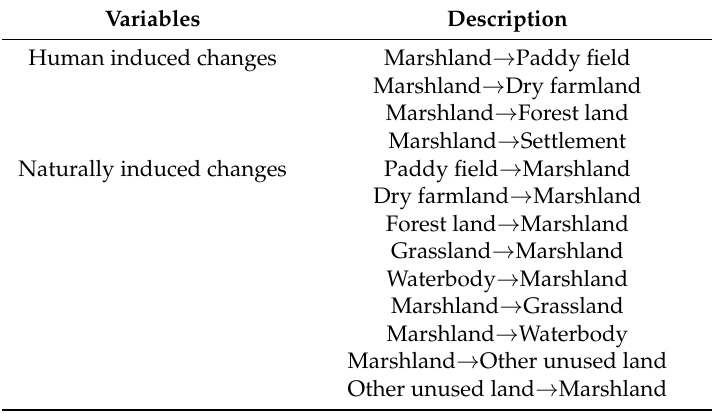
Table 1. LULCC types